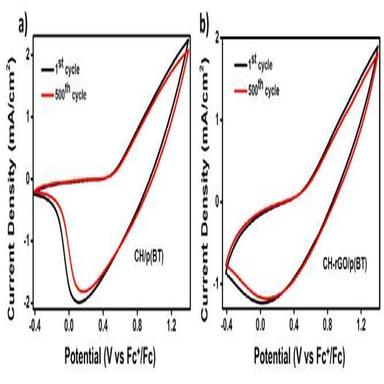
Stability graphs of a) CH/p(BT) b) CH/rGO/p(BT).